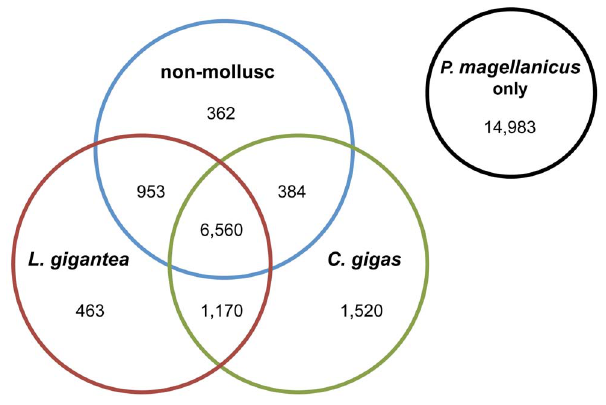
Figure 5. Venn diagram of P. magellanicus transcriptome sequences with significant blast hits against other animal genomes. The labels in each circle represent the animal genomes the P. magellanicus eye transcriptome was blasted against: the pacific oyster, Crassostrea gigas (green), the owl limpet, Lottia gigantea (red), and two non-mollusc genomes, Drosophila melanogaster and Mus musculus (blue). The number of sequences from P. magellanicus that did not match any other animal genome and are putatively unique to scallops are shown in a separate circle